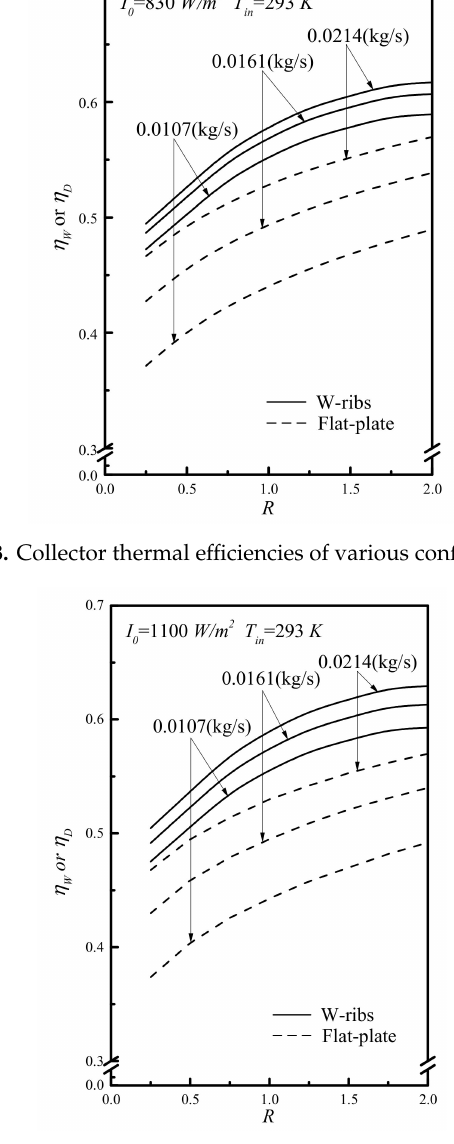
Figure 9. Collector thermal e ffi ciencies of various